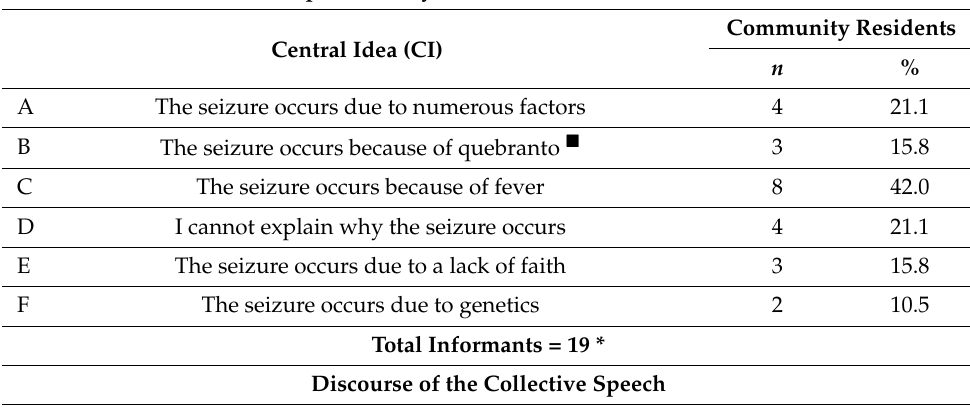
Table 2. Relationship between central idea (CI) of question 2, proportion of responses according to research participants and DCS for question